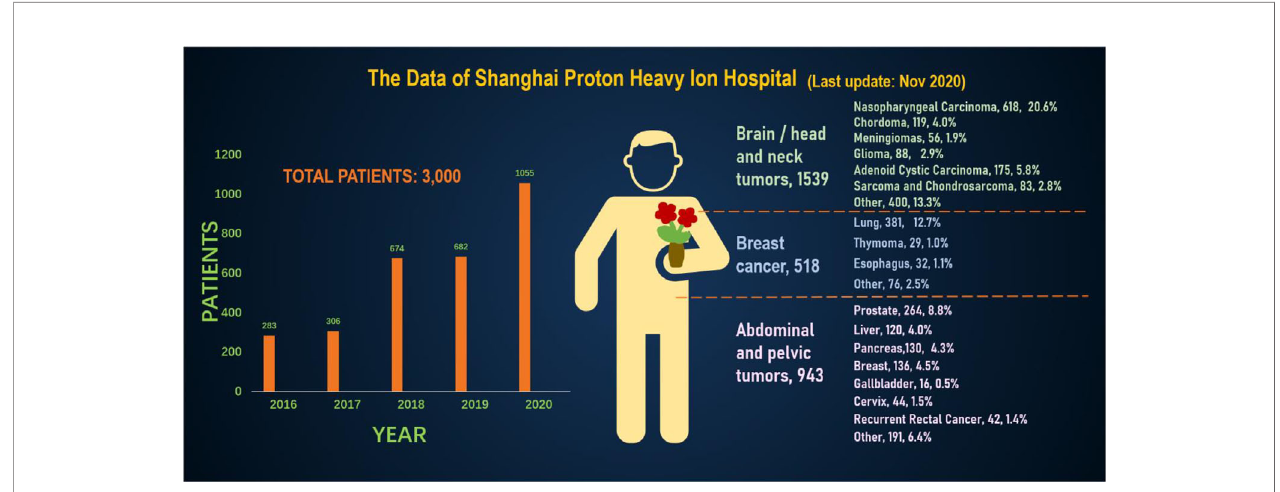
FIGURE 5 | The annual number of patients treated with heavy ion therapy alone or proton therapy alone or heavy ion combined with proton therapy in Shanghai Proton Heavy Ion Hospital for various cancer patients.